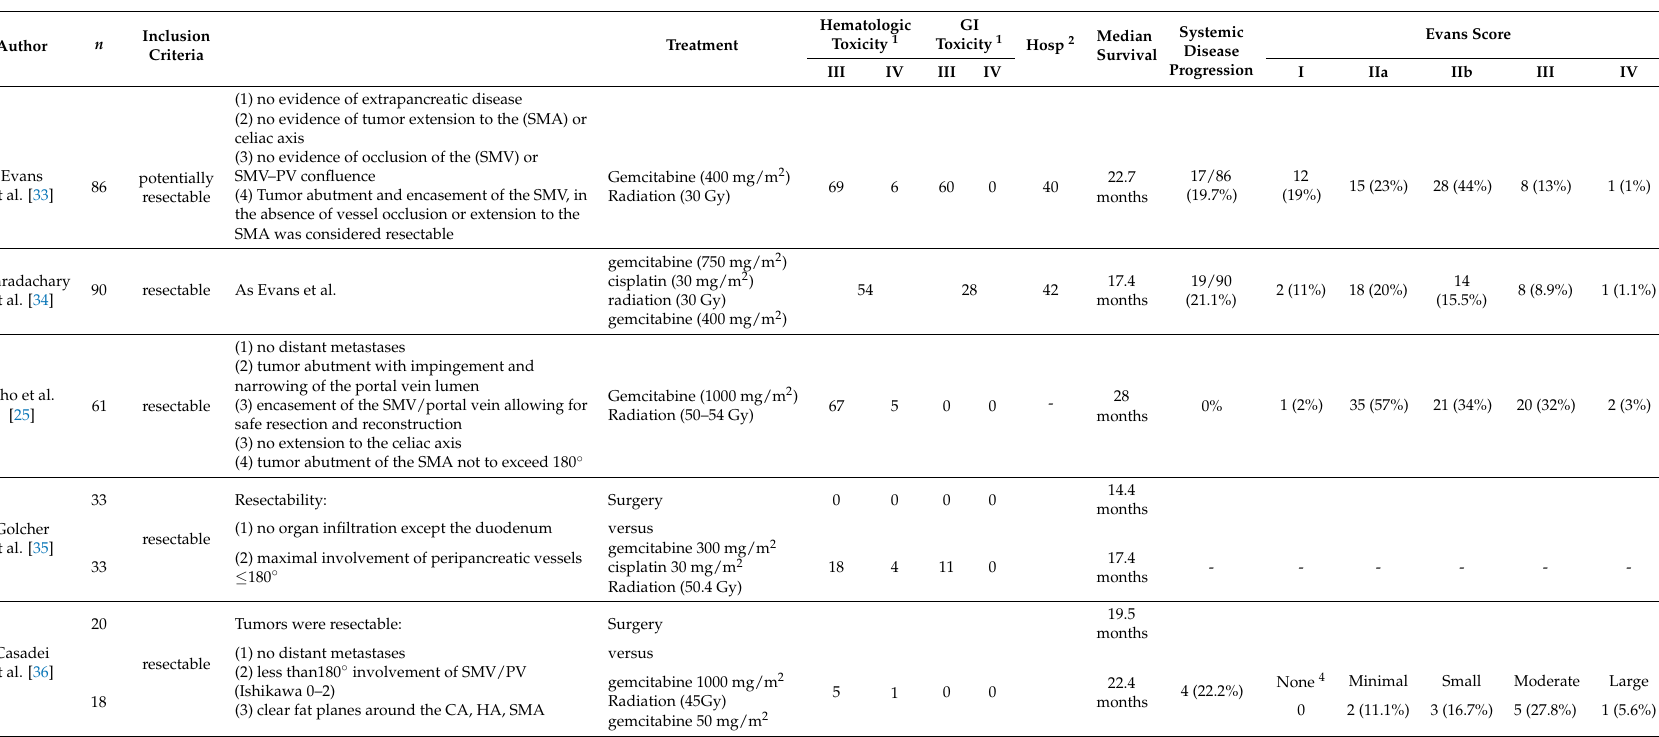
Table 2. Summary of studies on neoadjuvant chemo- and chemoradiation therapy for “resectable“ pancreatic